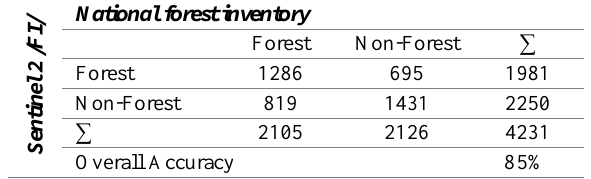
Figure 3. forest cover map 2015 to 2019 for FI whit NFI However, some forest areas were also detected outside the NFI area suggesting that the boreal forest area for study area could be beyond the defined premises of the NFI.